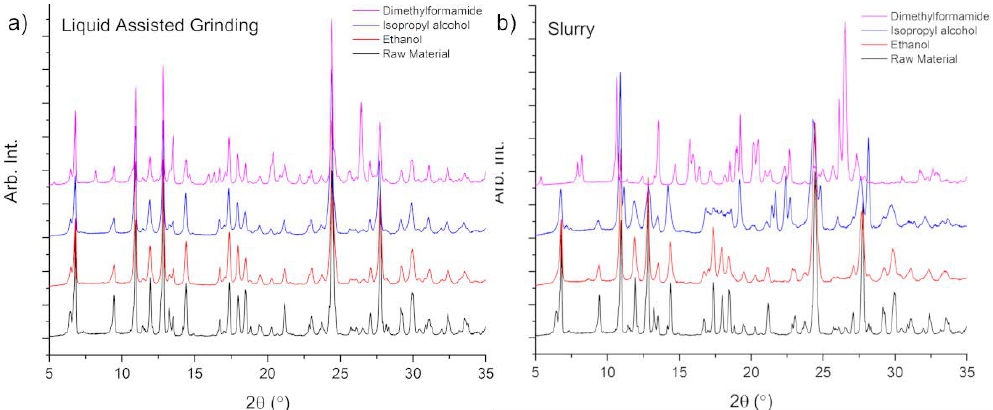
Figure 1. The X-ray powder di ff raction from the samples under liquid assisted grinding ( a ) and via slurry ( b ) for the new solid forms. The powder di ff raction patterns for all the solvent under study can be found in